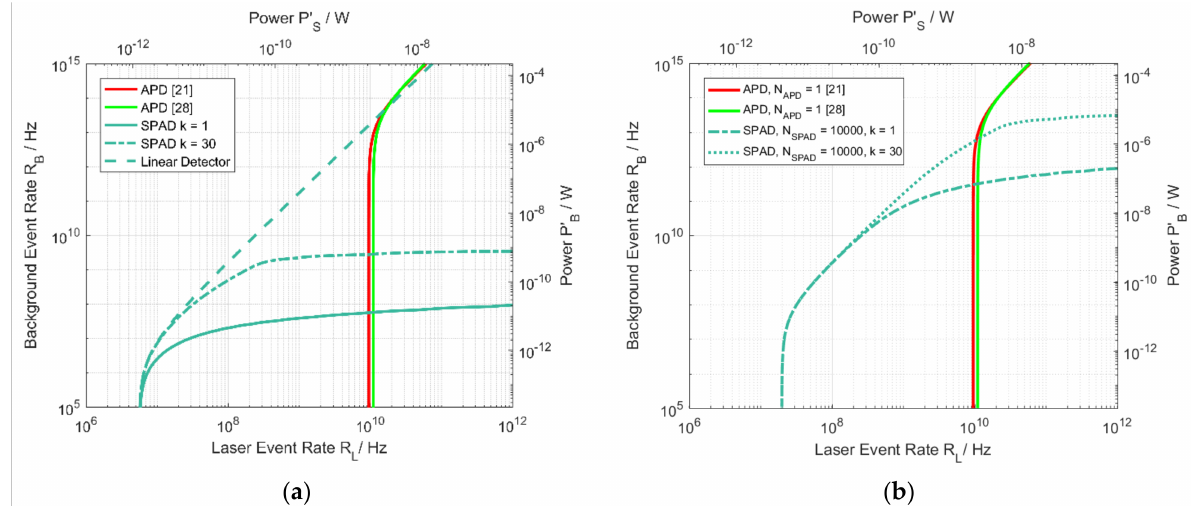
Figure 8. Contour lines for receiver performance when comparing a single APD to an equally sized SPAD detector ( a ) in different operation modes of the SPAD (single/multi-event detection) and ( b ) additionally for 10,000 SPAD pixels N SPAD . Contour lines according to (14) and (30) with values from Tables 1–3 at SNR = 3 are shown in each